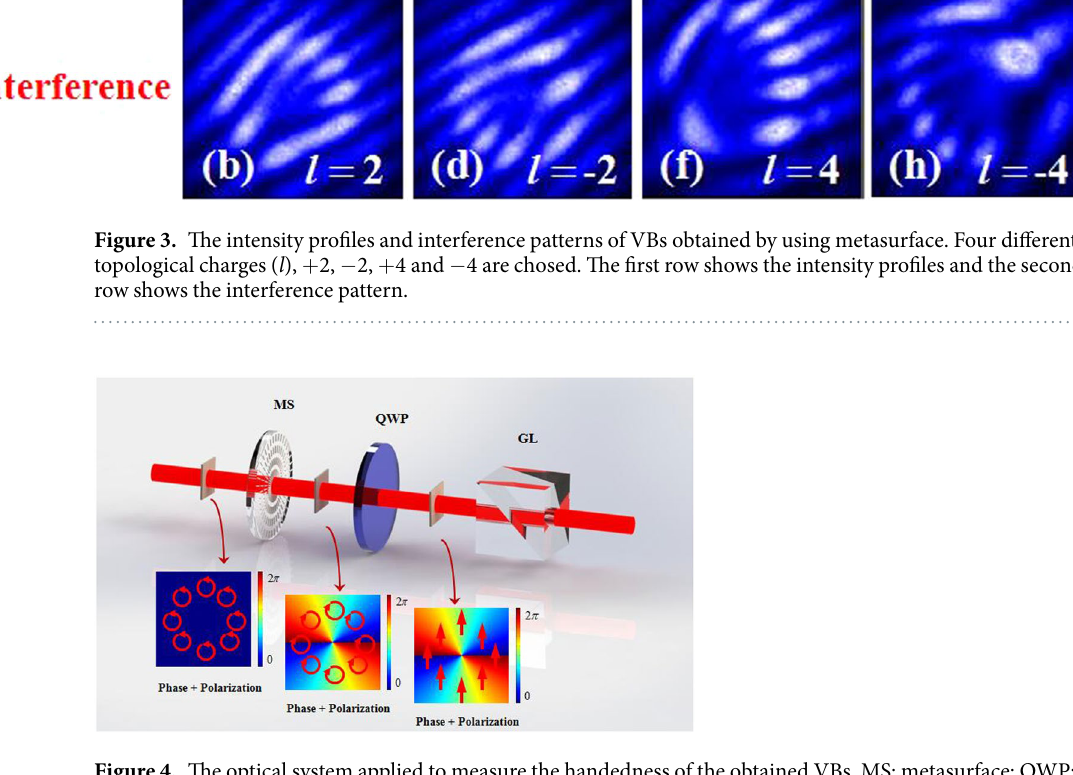
Figure 4. The optical system applied to measure the handedness of the obtained VBs. MS: metasurface; QWP: quarter-wave plate; GL: Glan laser polarizer. The metasurface generate a LCP (RCP) VB, a quarter-wave plate convert the LCP (RCP) to horizontal (vertical) polarization, and a Glan laser polarizer is used to measure the polarization state. Insets show the phase and polarization patterns in each step of this